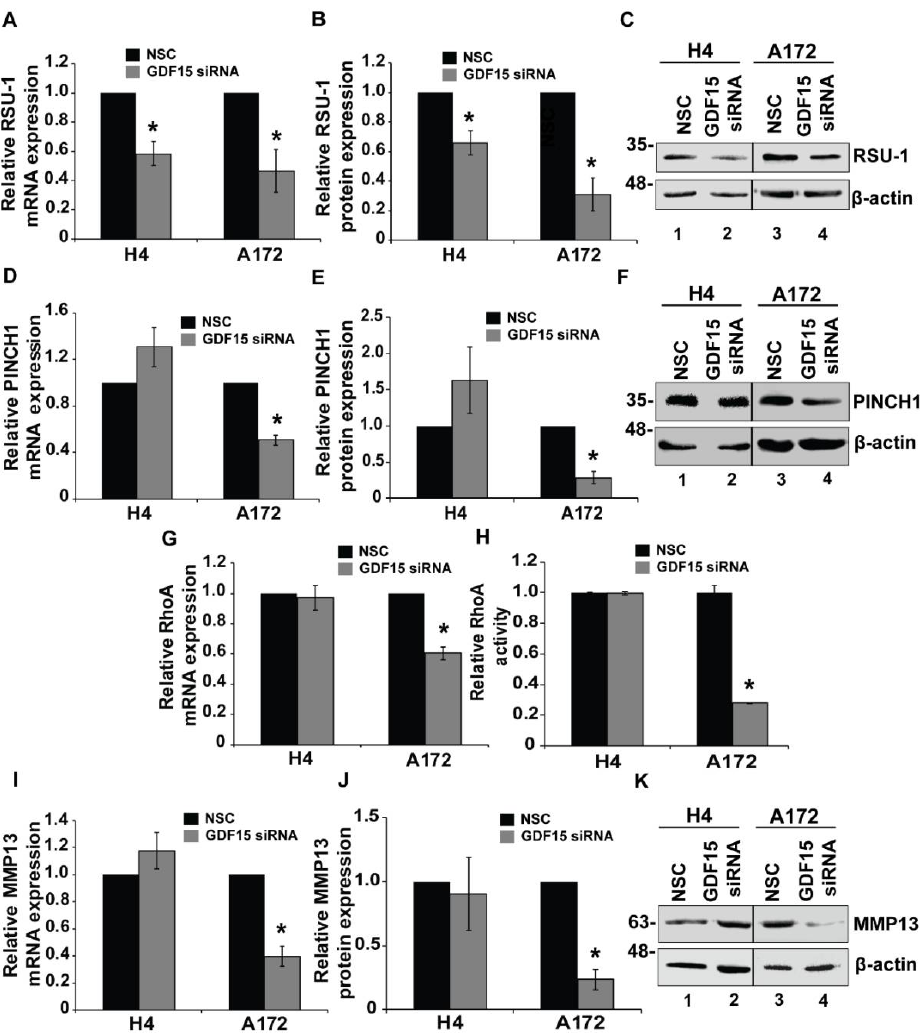
Figure 6. Effect of GDF15 silencing on RSU-1 , PINCH1 , RhoA and MMP-13 expression. ( A , D , G , I ) Relative GDF15 , PINCH1 , RhoA and MMP13 mRNA expression respectively in H4 and A172 cells upon GDF15 silencing. Three independent real-time PCR experiments were conducted and data were analyzed using the ΔΔCt method having control-treated cells as calibrators for each cell line. ( H ) Relative RhoA activity 24 h post rhGDF15 treatment on H4 and A172 cell lines. ( C , F , K ) Representative image from Western blot analysis displaying RSU, PINCH1 and MMP13 protein expression after GDF15 silencing. ( B , E , J ) Graphs representing quantification of RSU-1, PINCH1 and MMP13 protein expression for each cell line using ImageJ software. Two immunoblots from independent experiments were used for the quantification. Asterisks indicate a statistically significant difference ( p < 0.05) compared to NSC data.